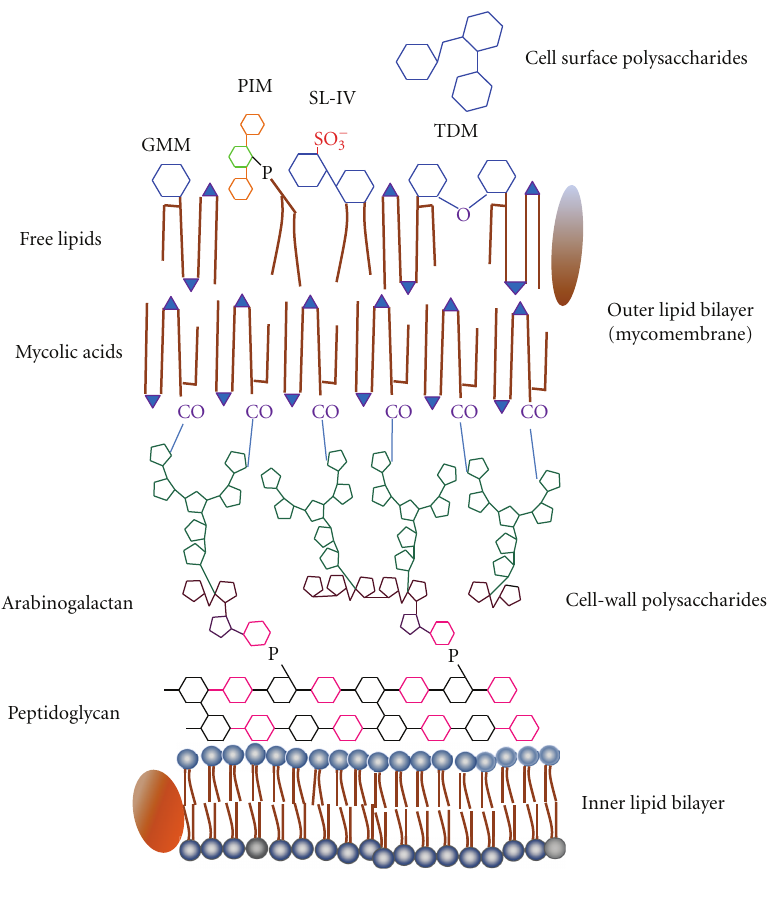
Figure 1: Proposed ultrastructural array of M. tuberculosis cell wall. Cell wall includes a great variety of lipids (depicted in brown, with polar functional groups in blue) and sugars (schematized by hexagons and pentagons in di ff erent colors). Surrounding the plasma membrane, cell-wall peptidoglycan is attached to another polysaccharide, the arabinogalactan. Long-chain fatty acids, the mycolic acids, are attached to arabinogalactan through ester linkages. An outer lipid bilayer called mycomembrane is formed by mycolic acids and free amphipathic lipids. Finally, some strains display free saccharides, such as glucan, at the outermost layer. GMM, glucose monomycolate; PIM, phosphatidylinositol mannoside; SL, sulfatide; TDM, trehalose dimycolate or cord factor. Cell-wall proteins are depicted in arbitrary positions. Figure is out of